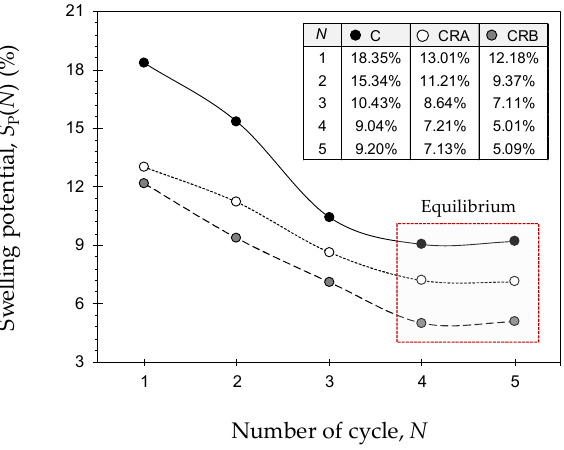
Figure 4. Variations of swelling potential against the number of applied cycles for the tested samples.